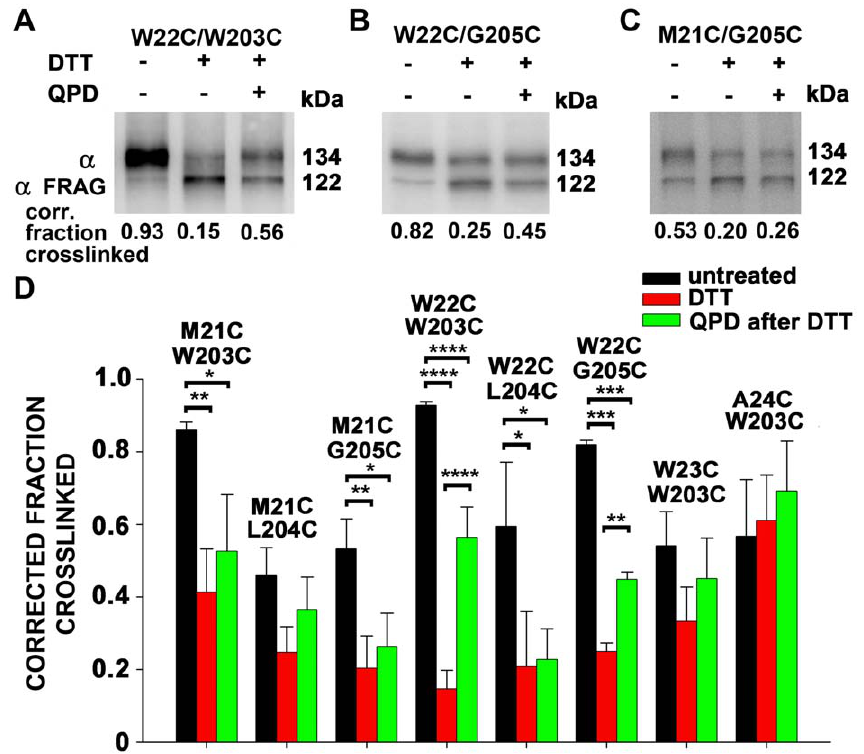
not further treated, treated with 10 mM DTT, or treated with 10 mM DTT and 40 m M QPD. The conditions were the same as in Fig. 2. Cells were lysed. Solubilized BK a was captured on Neutravidin beads, cleaved with HRV-3c protease between S0 and S1, electrophoresed, and immuno-blotted with an anti-BK a -C-terminal-epitope antibody. The extents of crosslinking were calculated from the relative integrated densities of the full-length a band and the truncated (Frag) a band, corrected by the efficiency of HRV-3c cleavage, determined individually for each Cys pair in each experiment (not shown). The efficiencies of cleavage were approximately 70%. N=2–4. Mean + SD. N=2–4 experiments, each with duplicate determinations. * P , 0.05, **P , 0.01, *** P , 0.001, ****, P , 0.0001 by one-way Anova followed by Tukey’s post-hoc analysis.